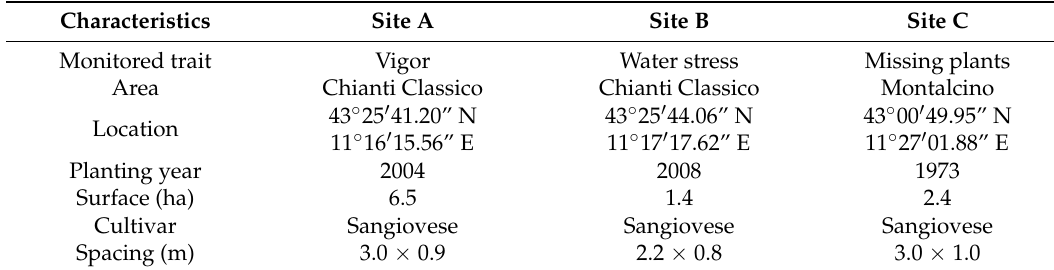
Table 1. Experimental